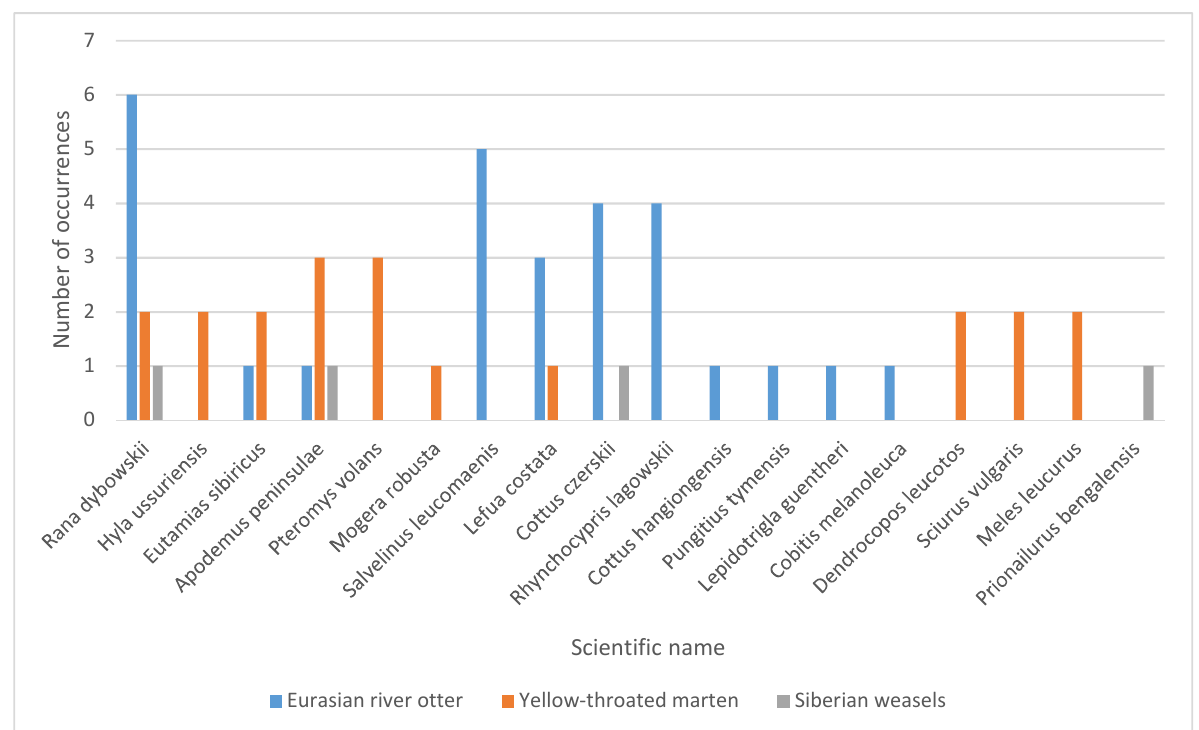
Figure 2. Vertebrate prey species molecularly identified in scats of three Mustelidae collected the Northeast Tiger Leopard National Park in northeast China.